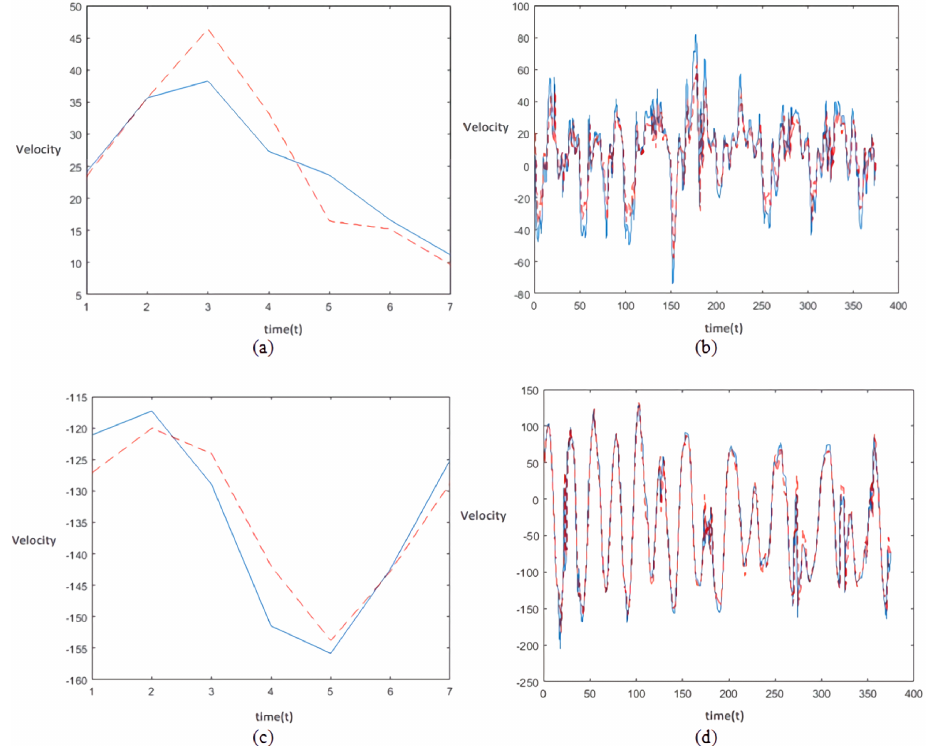
Fig. 5 (a) U short-term prediction results (b) U long-term prediction results (c) V short-term prediction results (d) V long-term prediction